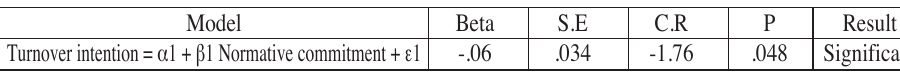
Normative Commitment and Turnover Intention